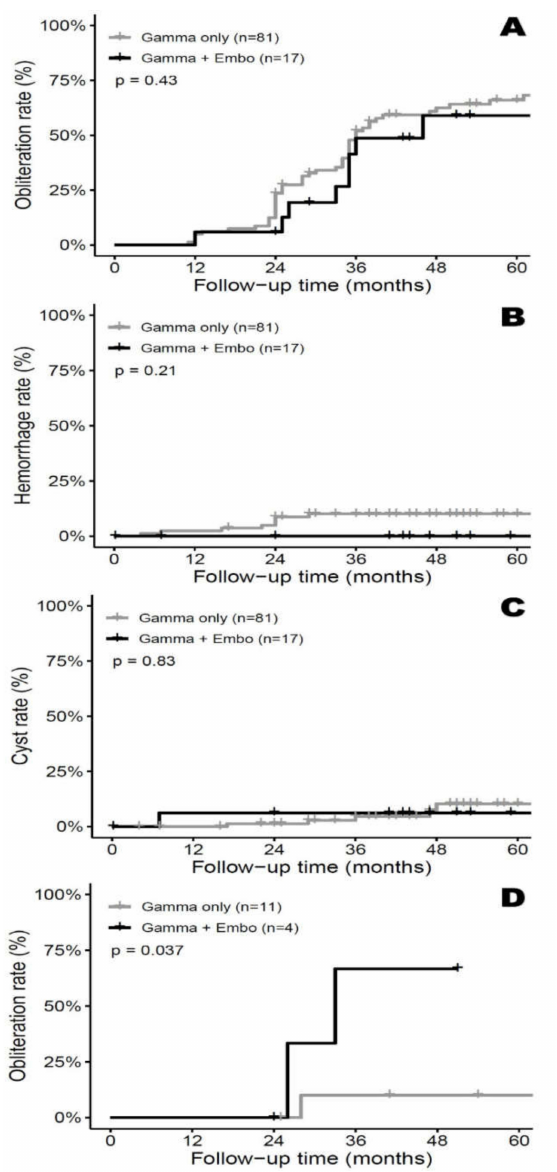
Figure 1. ( A ) Kaplan-Meier curves for total obliteration confirmed by magnetic resonance (MR) imaging / MR angiography or cerebral angiogram after gamma knife radiosurgery (GKRS) for ruptured arteriovenous malformations (AVMs) with and without endovascular embolization. No statistical di ff erence was noted between the 2 groups (Log-rank test, p = 0.43). ( B ) Kaplan-Meier curves for repeat hemorrhage after GKRS for ruptured AVM with and without endovascular embolization. No statistical di ff erence was noted between the 2 groups (Log-rank test, p = 0.21). ( C ) Kaplan-Meier curves for delayed cyst formation after GKRS for ruptured AVM with and without endovascular embolization. No statistical di ff erence was noted between the 2 groups (Log-rank test, p = 0.83). ( D ) Kaplan-Meier curves for total obliteration confirmed by MRI / MRA or cerebral angiogram after GKRS for ruptured AVM belonging to SM grade III and IV with and without endovascular embolization. Statistical significance was noted between the 2 groups (Log-rank test, p =